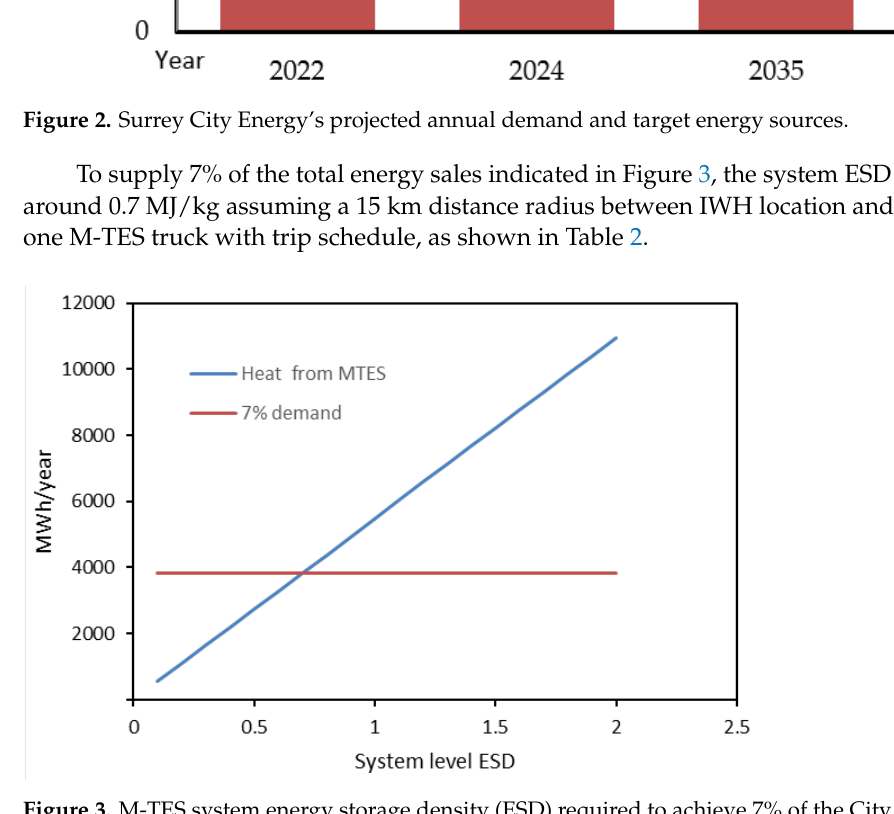
Figure 2. Surrey City Energy’s projected annual demand and target energy sources.